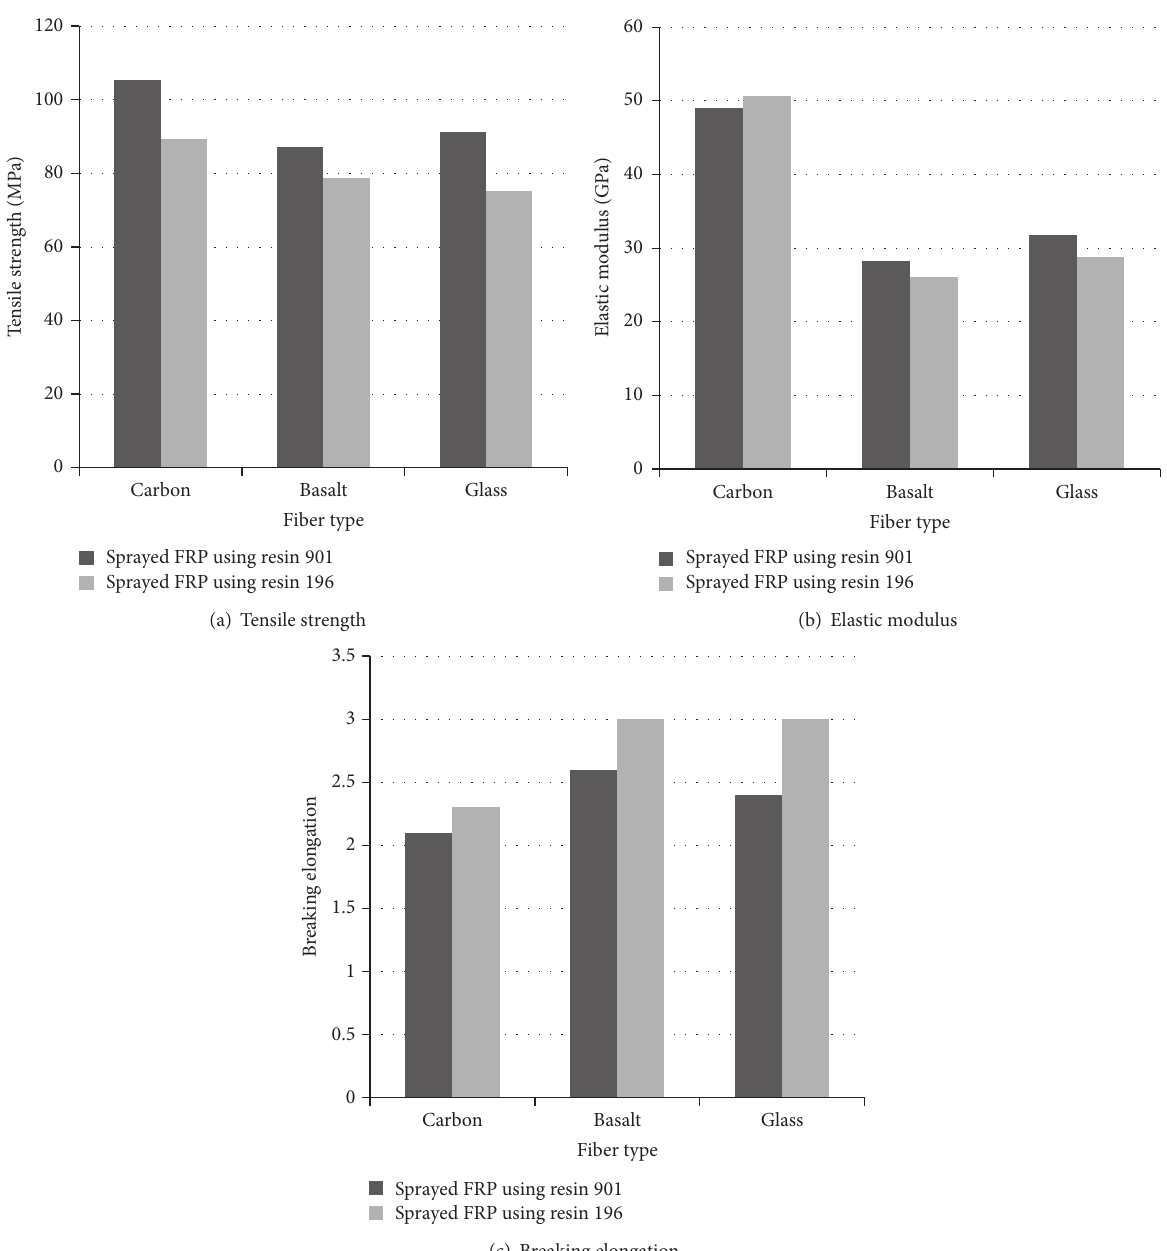
Figure 12: Comparison of tensile properties of sprayed FRP using different fiber